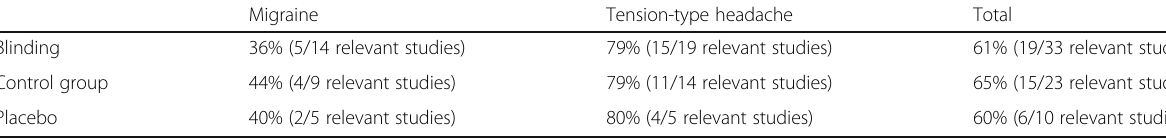
Table 3 An overview on the use of blinding, control groups and placebo Migraine Tension-type headache Blinding